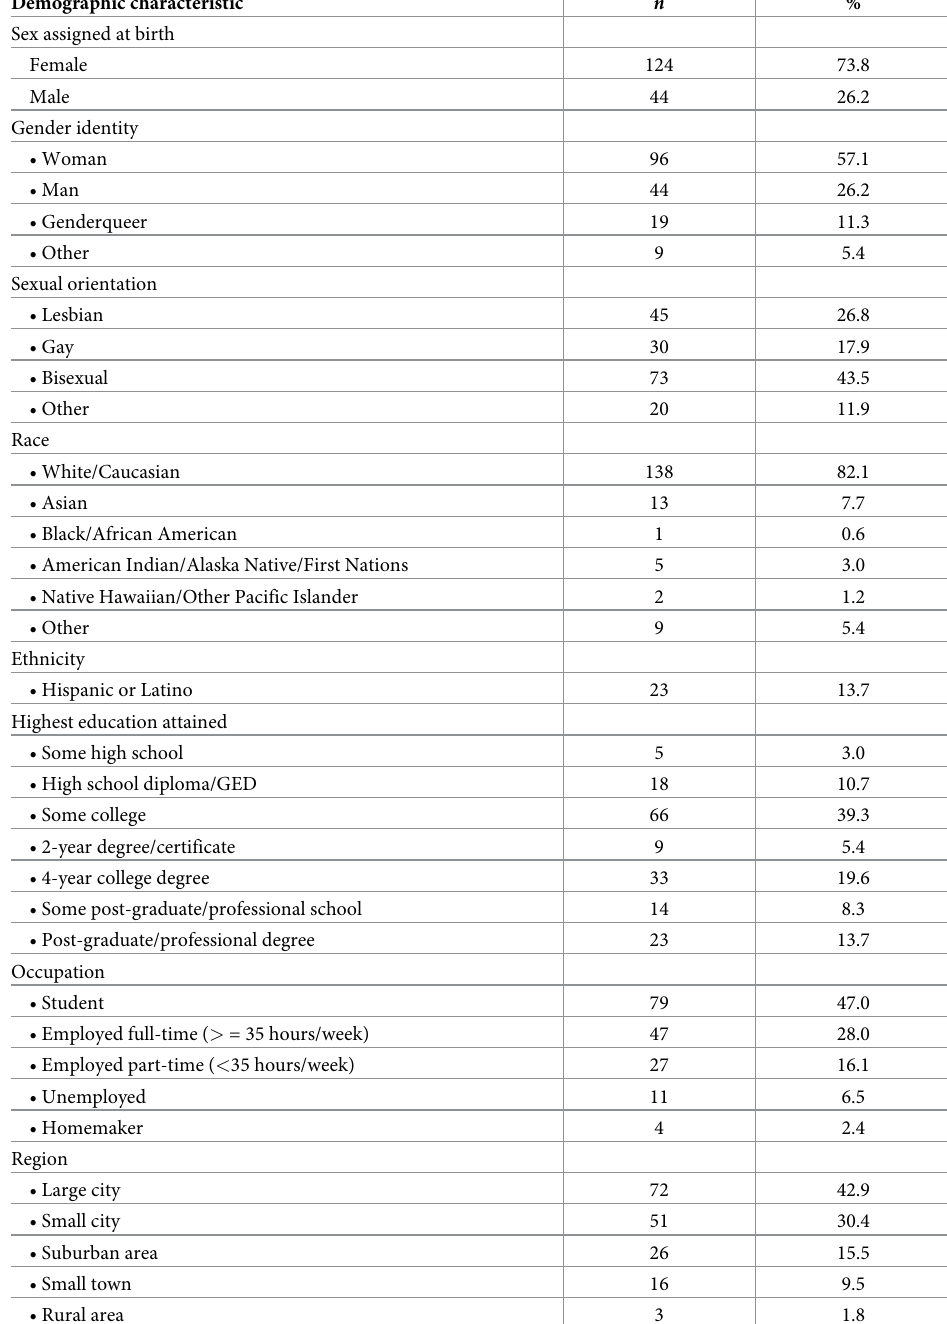
Table 1. Demographic characteristics of the